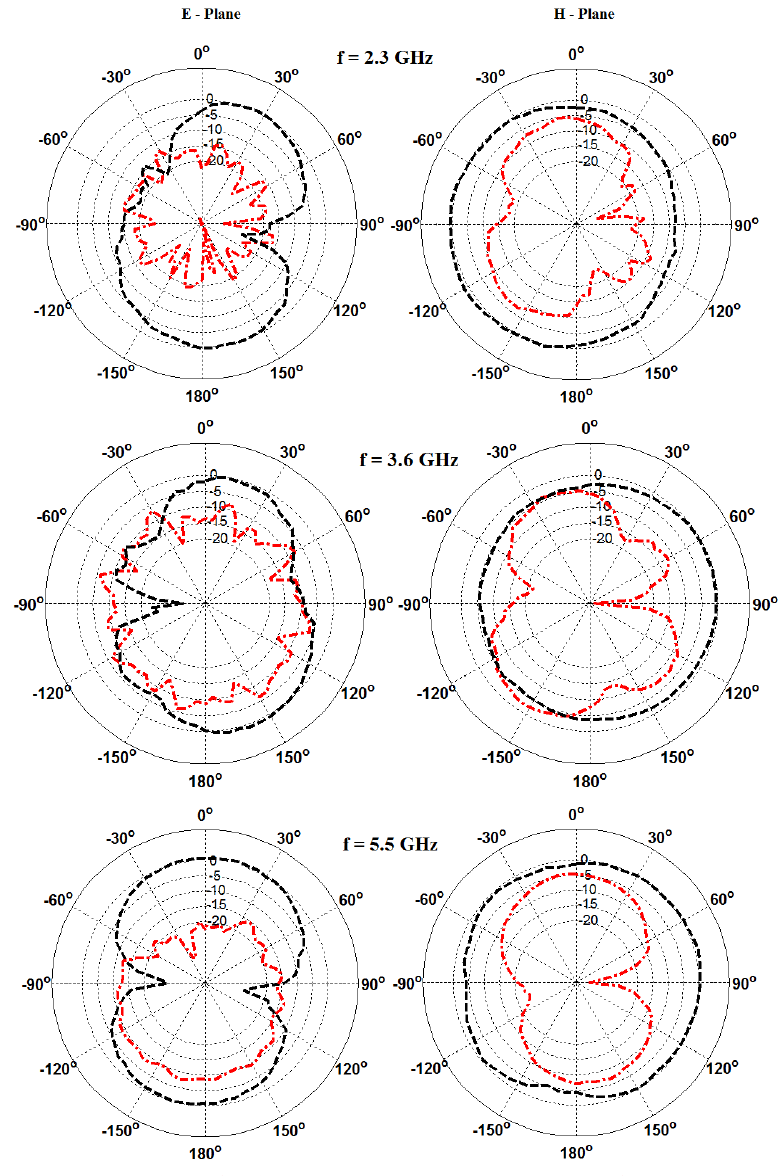
Figure 7: Uniplanar triple wideband band ACS fed antenna measured patterns. (red color indicates Croos- Pol and black color indicates Co-Pol)